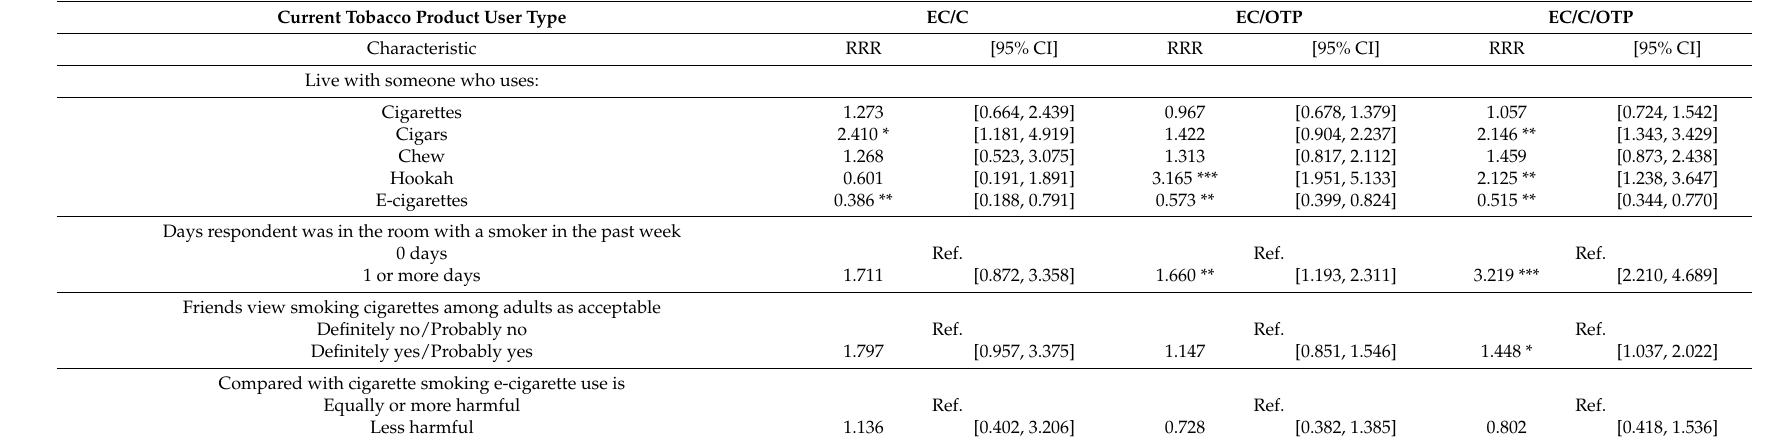
Table 3. Current Tobacco Product Use among Youth Current Smokers in Florida, Florida Youth Tobacco Survey,